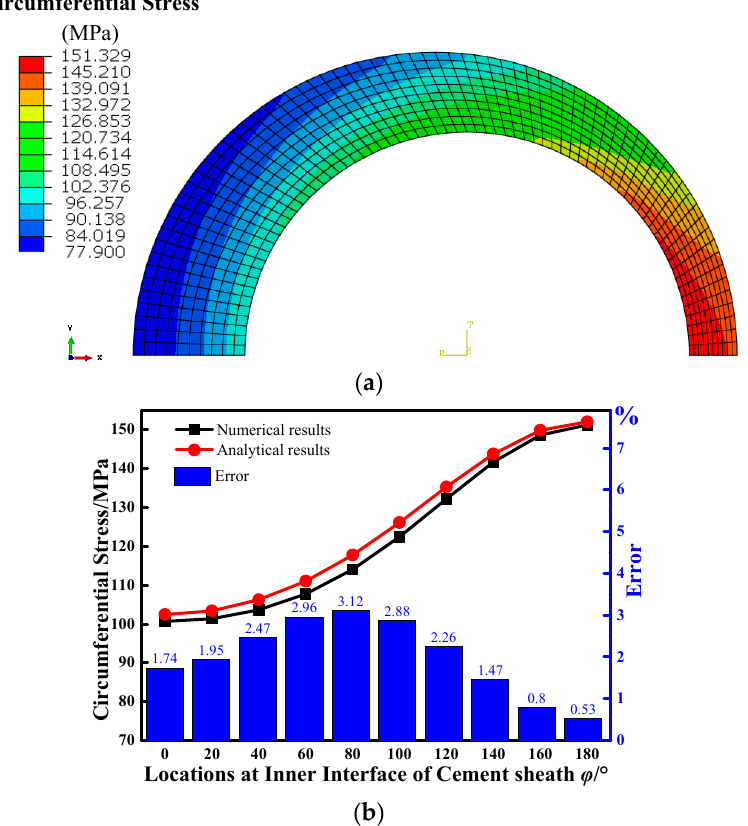
Figure 5. ( a ) FEA results for the circumferential stress on the inner interface of the cement sheath; ( b ) comparisons between ABAQUS numerical results and analytical results.